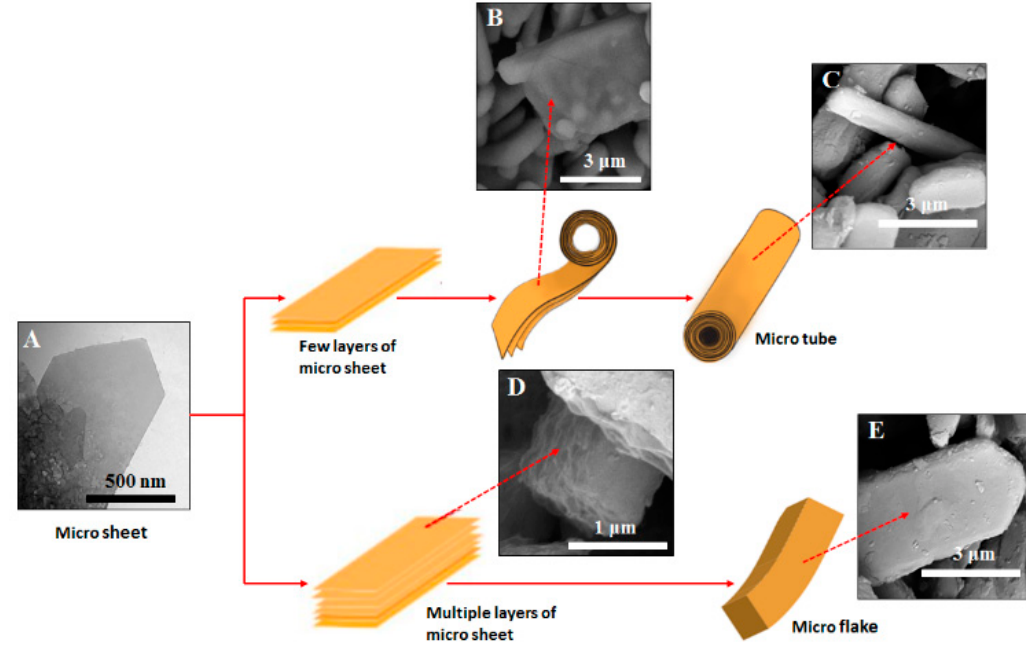
Scheme 2. Schematic representation of the formation of micro rods and micro flakes in the